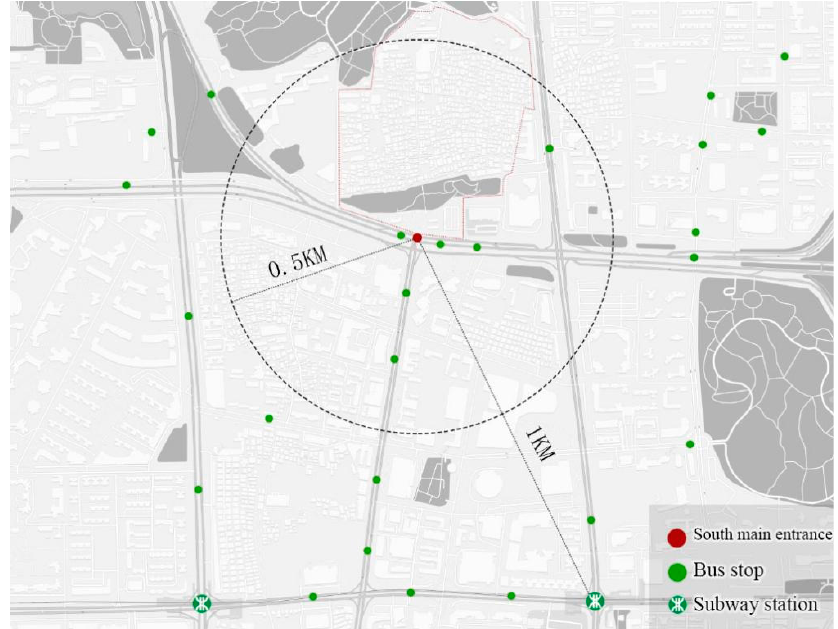
Figure 9. Exterior traffic situation of Nantou Ancient City.